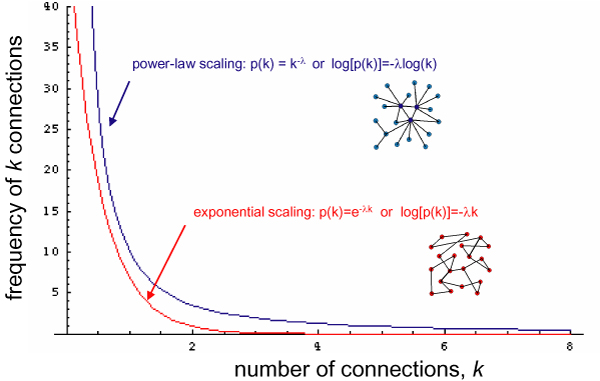
Exponential and power-law curves. Illustration of exponential and power-law curves, showing how power-law generates a larger number of highly connected nodes. Two network diagrams illustrate hypothetical differences in network connectivity expected for random (exponential) and scale-free networks.